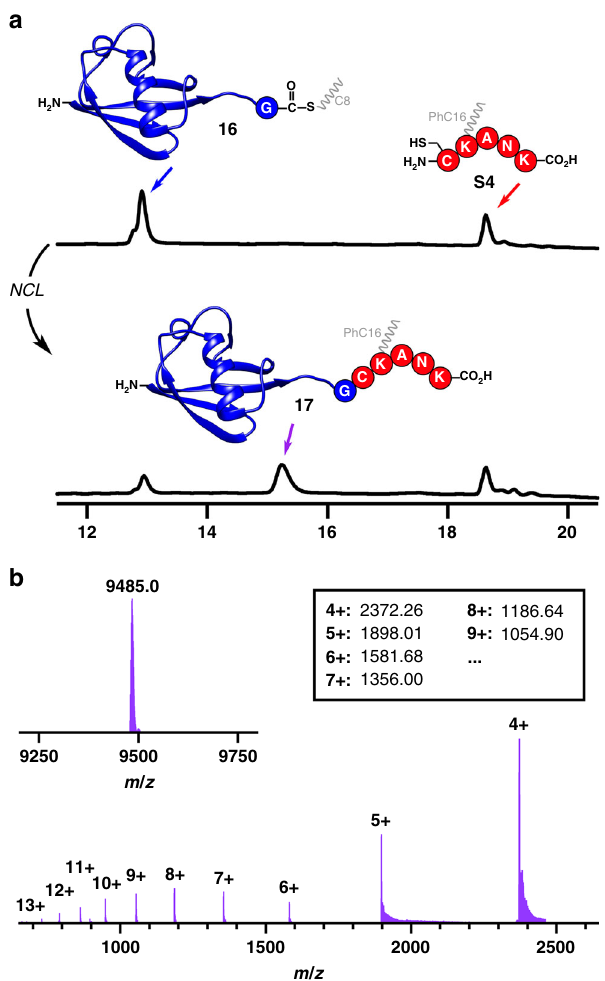
Fig. 5 Derivatization of the natural protein Ubiquitin by lipid-facilitated NCL. a HPLC (210 nm) traces corresponding to the precursors Ubi- α COSC8 ( 16 ) and CK(PhC16)ANK ( S4 ) (top) and the ligated product Ubi- CK(PhC16)ANK 17 (after 5 h of NCL reaction; bottom). Retention times were veri fi ed by MS. b ESI-TOF MS spectrum of the ligated product 17 . Deconvoluted spectrum calculated from this ESI-TOF spectrum is also shown in the top left. The deconvolution value (9485.0) corresponds with the molecular weight of the